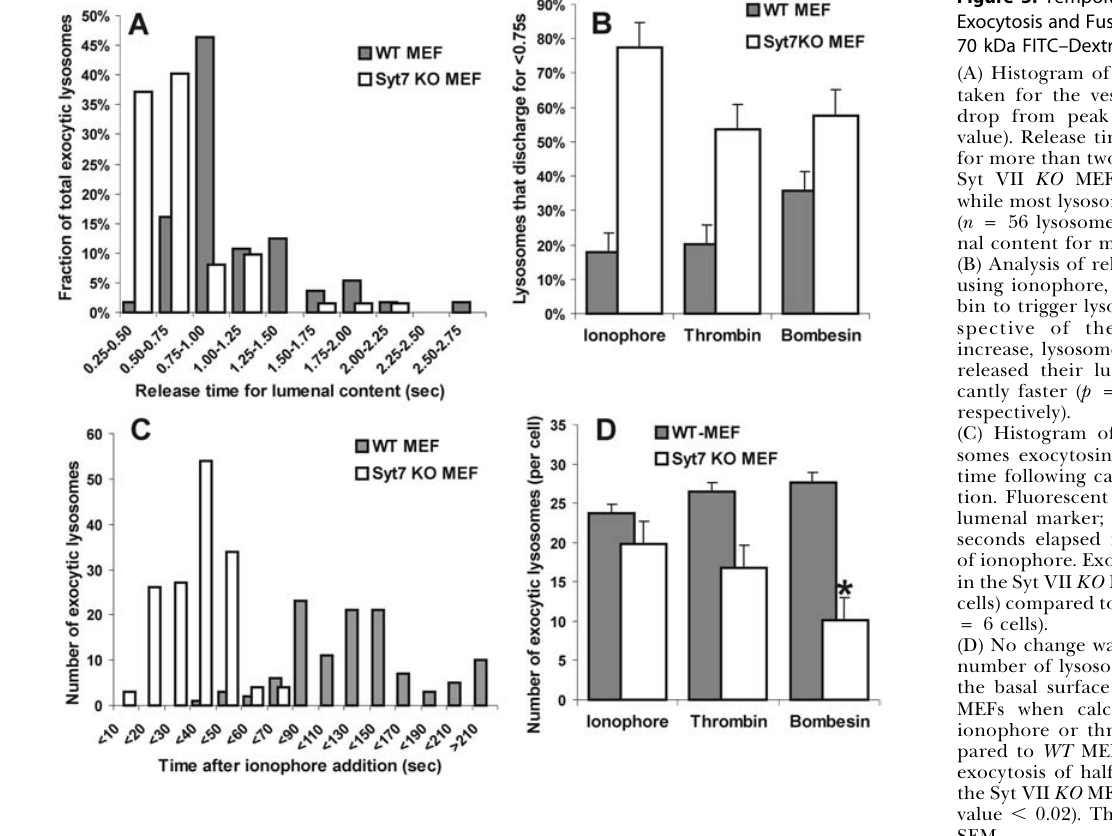
Figure 5. Temporal Analysis of Lysosomal Exocytosis and Fusion Pore Opening Using 70 kDa FITC–Dextran as Lumenal Marker (A) Histogram of the release time (time taken for the vesicular fluorescence to drop from peak to postfusion resting value). Release time was less than 0.75 s